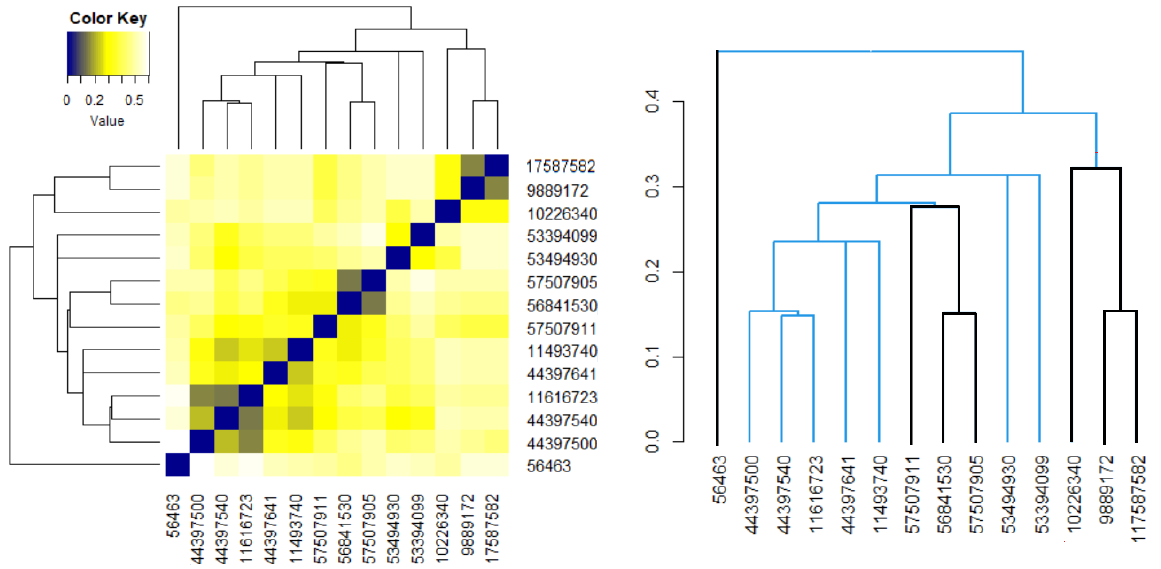
Figure 6. The heatmap and dendrogram for all molecules. The black branches correspond to the molecules in the first group.